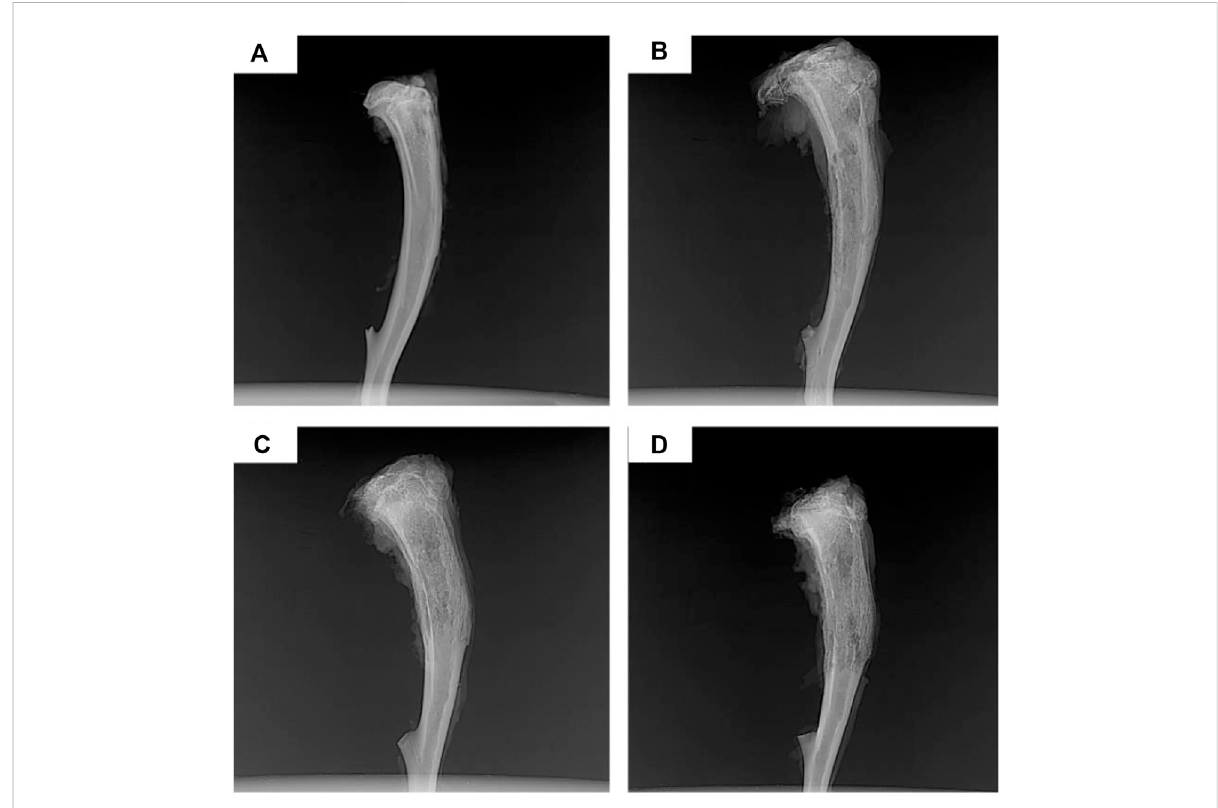
FIGURE 6 X-raysofchronic-osteomyelitis-modelratsafter4 weeksoftreatments: (A) Cipro fl oxacin-PLGCsystem, (B) purecipro fl oxacin, (C) blankPLGC, and (D) no treatment. Reproduced with permission from Liu et al. (2020). Copyright © 2020 The